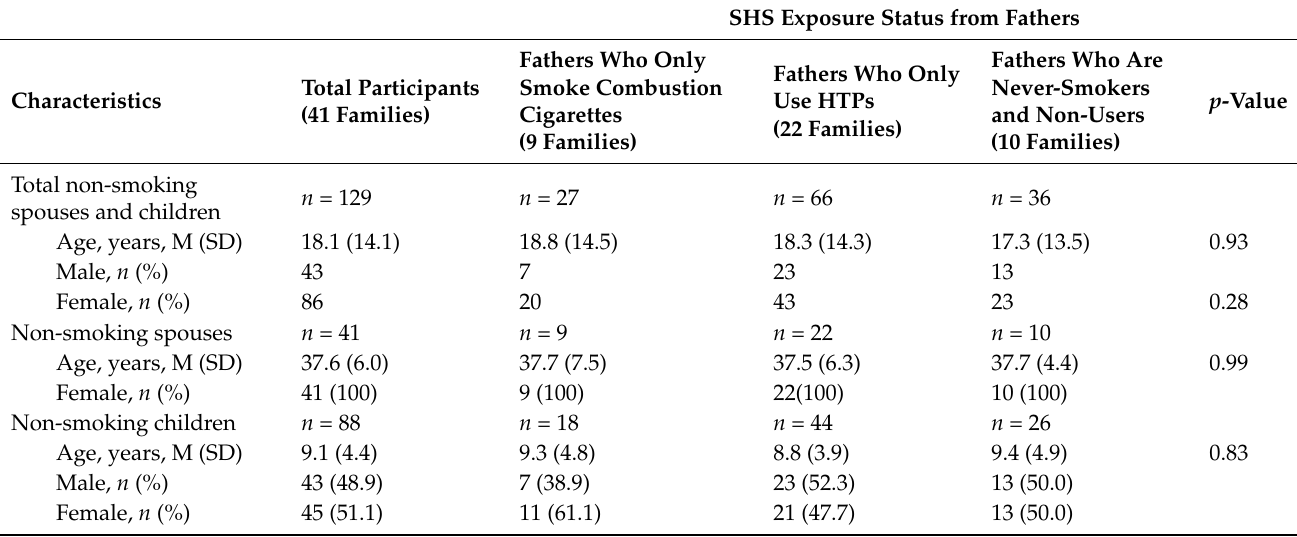
Table 2. The characteristics of the study